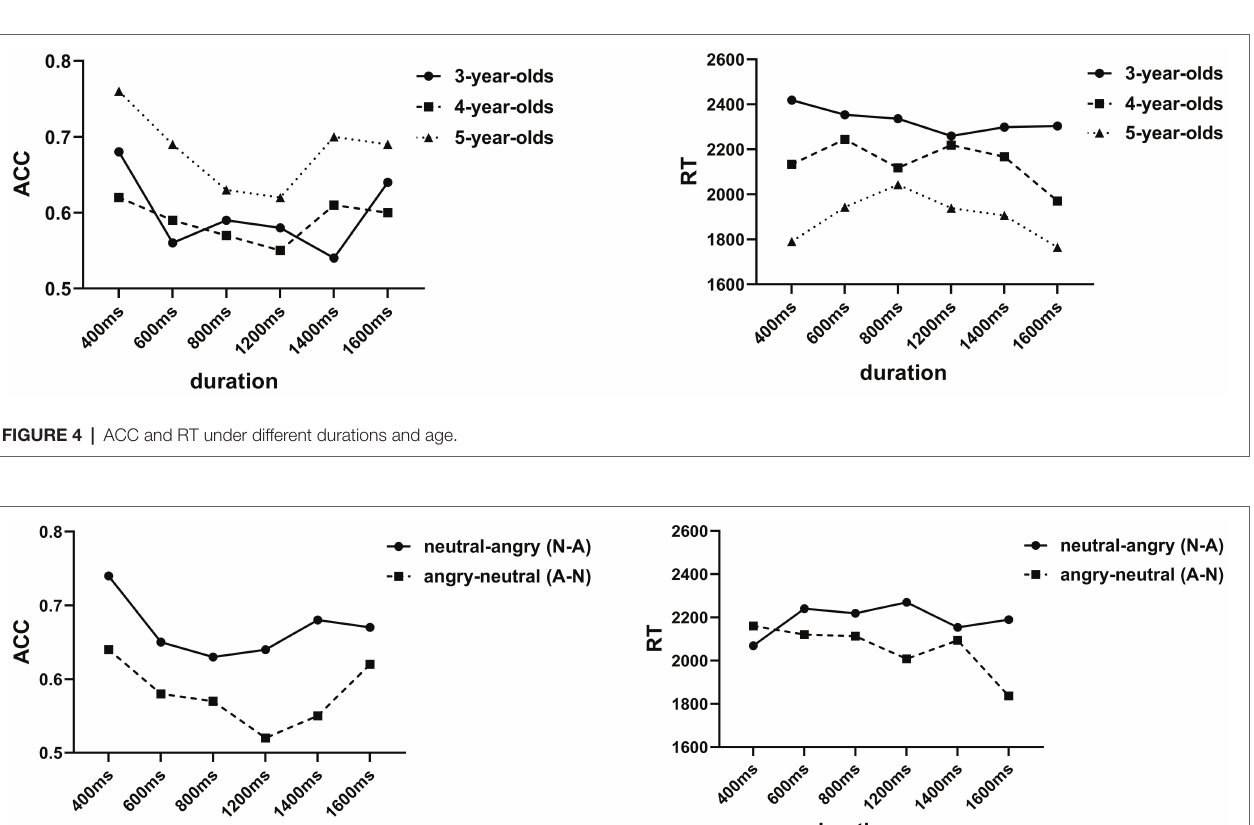
FIGURE 3 | Example trial sequences: neutral-angry (N-A) condition and angry-neutral (A-N) condition.